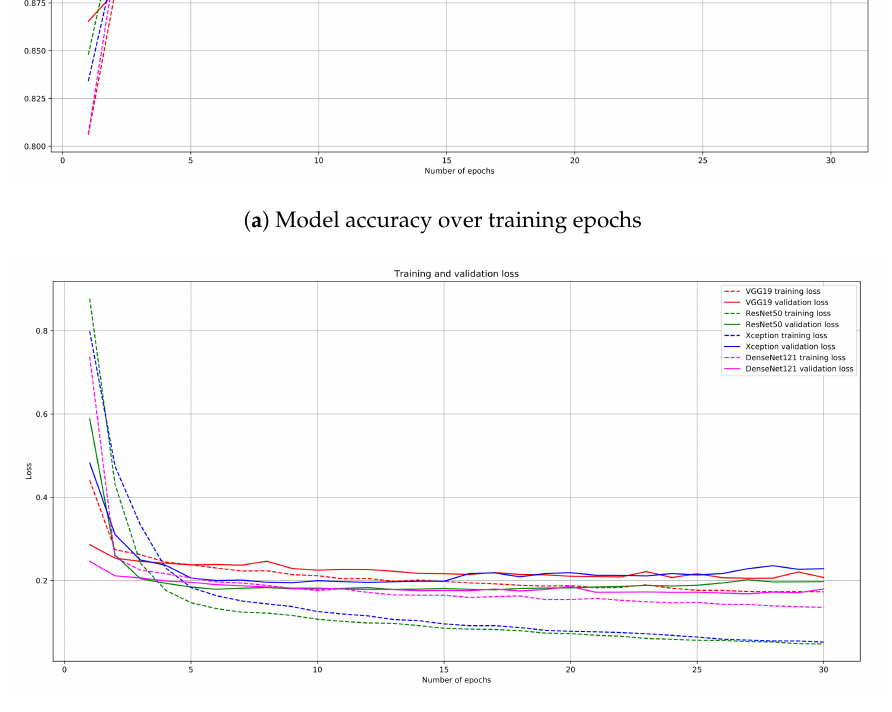
Figure 12. Line plot of: ( a ) classification accuracy and ( b ) loss function—over training epochs when optimizing the